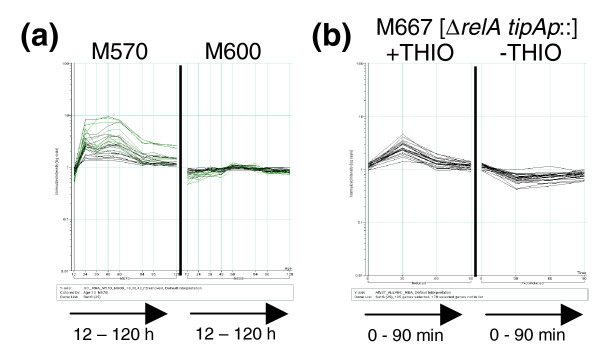
Genes in QT cluster 6 that were identified as being significantly over-expressed in (a) M570 (relA- ppGpp-) relative to M600 (relA+ ppGpp+) during growth on agar plates, are also induced (b) following addition of thiostrepton (THIO) to strain M667 [ΔrelA tipAp::]. In each panel, the x-axis represents time (culture age in (a); time after induction in (b)), and the y-axis is normalized transcript abundance in log10 scale.